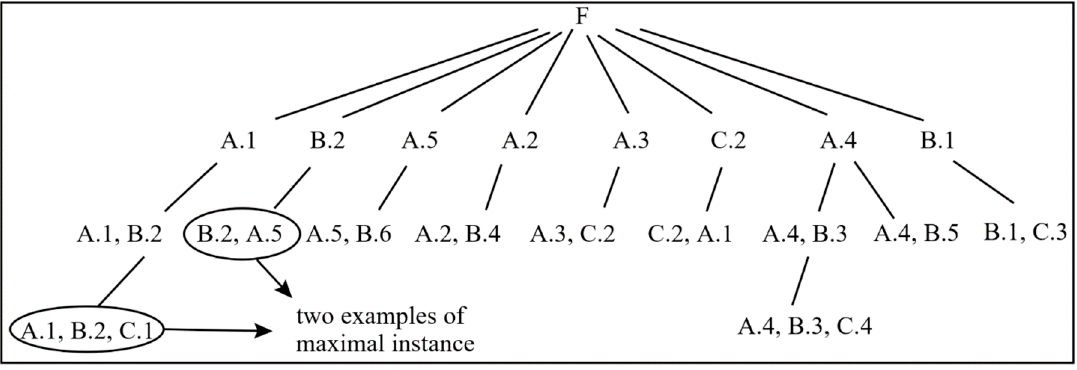
Figure 3. The process of constructing a row instance (RI) ‐